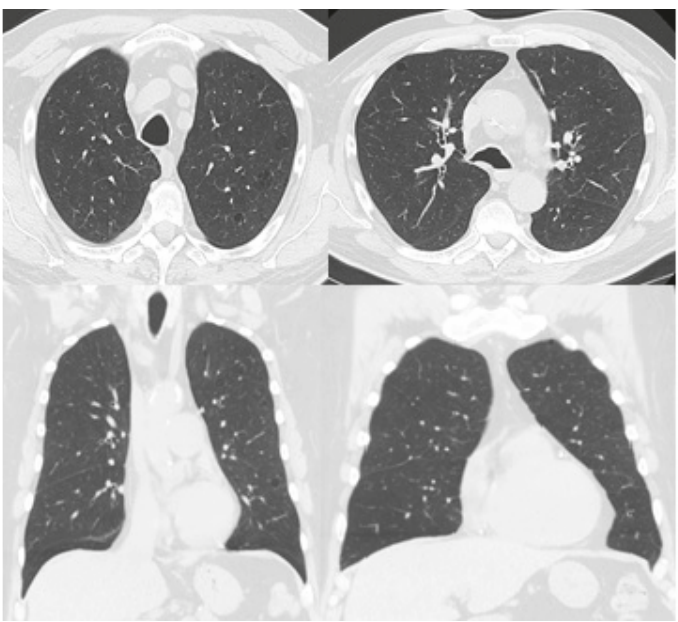
Figure 3: Follow-up HRCT images at the same level and planes as Figure 2 show resolution of the ground-glass nodules with persistent lung